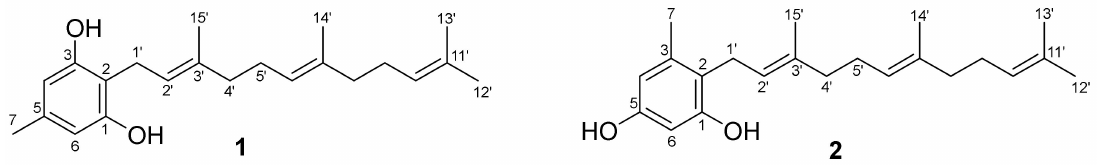
Figure 2. Structures of the naturally occurring compounds 1 and 2